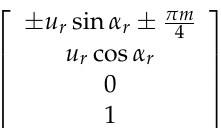
Figure 12. The tooth surface coordinate system of generating rack. The global coordinate systems of both the helical and curvilinear tooth generating rack are expressed as S r ( O r – X r Y r Z r ), abbreviated as S r , as shown in Figure 12a,d. In Figure 12b, S t ( O t – X t Y t Z t ), abbreviated as S t , is the cross-section coordinate system of helical rack in the tooth width direction. O t X t coincides with the rack pitch line and O t Y t coincides with the cogging symmetry line. H a and H b are the addendum and dedendum, respectively. M is the module, α r is the profile angle and u r is the tooth height direction parameter. In Figure 12e, S n ( O n – X n Y n Z n ), abbreviated as S n , is the normal section coordinate system of curvilinear rack. The normal section tooth profile of the curvilinear rack is the same as the cross-section tooth profile of the helical rack in the tooth width direction. Figure 12c,f show the transformation process from coordinate systems S t and S n to S r , respectively. β r and b r are the helical angle and tooth width parameter of the helical rack respectively. θ r and ρ r are the arc angle and arc radius of the curvilinear rack, respectively. m is the module of the rack.